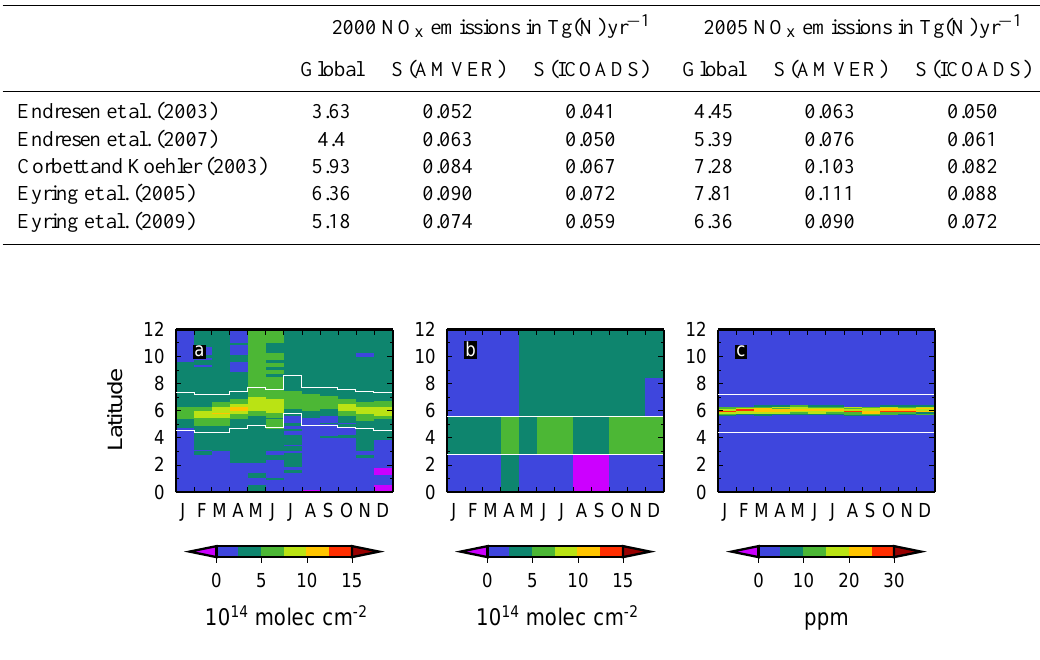
Fig. 3. Monthly zonal mean NO 2 tropospheric excess columns (a) derived from SCIAMACHY measurements from 2003 to 2008 using the DOAS technique and the tropospheric excess method (TEM); (b) derived from ECHAM5/MESSy1 model simulations from 2000 to 2005 and the TEM. (c) Zonal mean AMVER ship activity measured in ppm of global ship traffic (Wang et al., 2008). The zonal average includes data from 83 ◦ E to 94.2 ◦ E. White lines indicate the northern and southern border of region S.